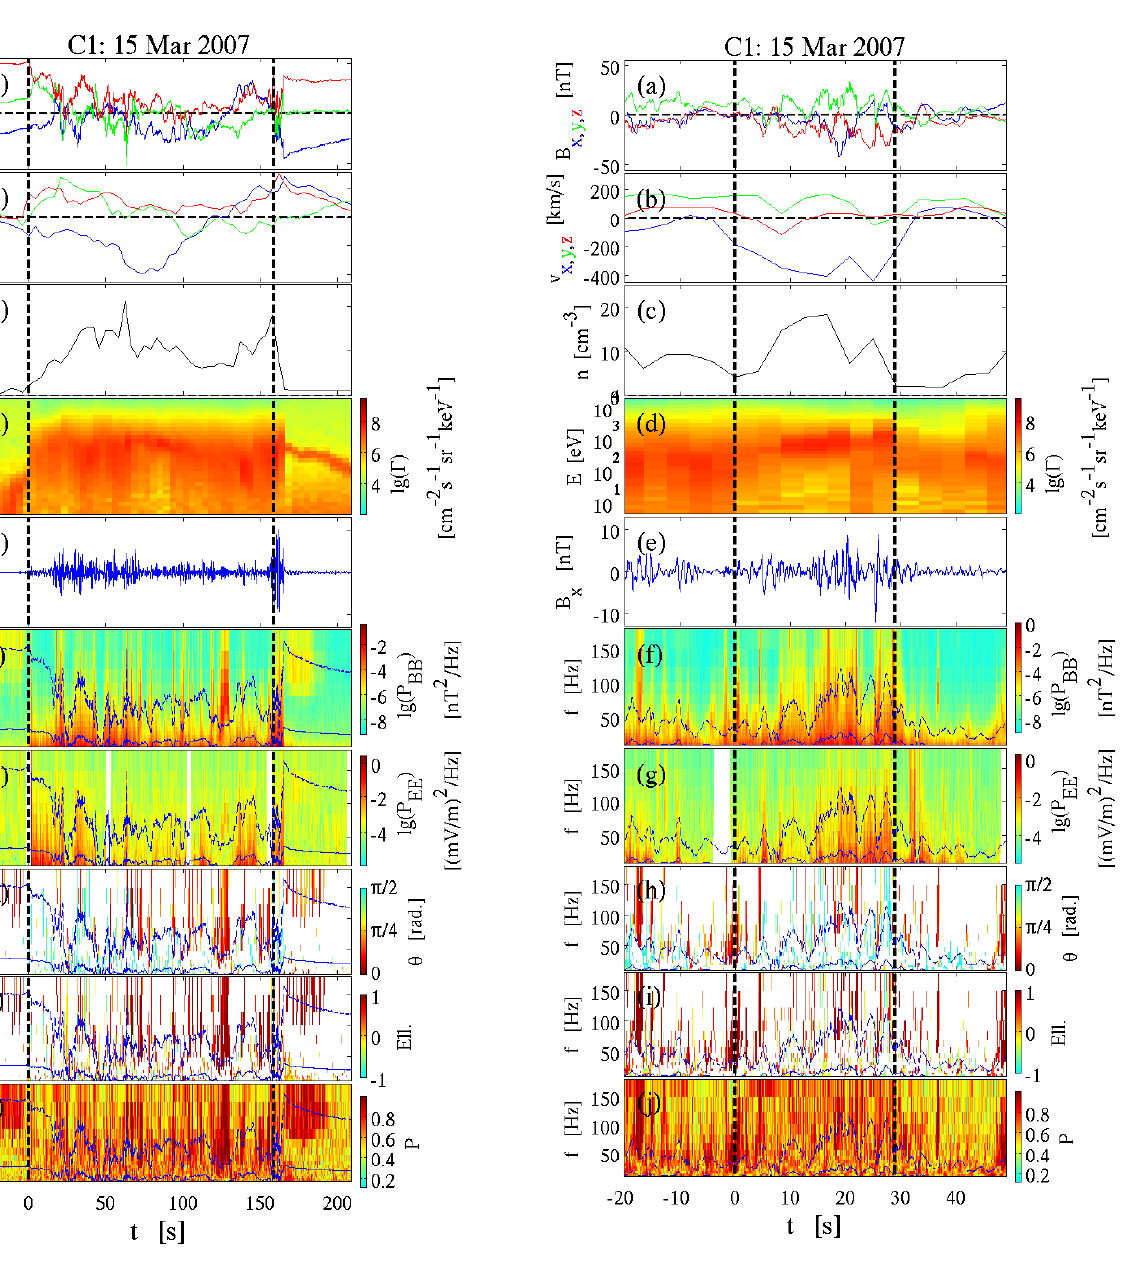
Figure 6. Data obtained by Cluster 1 on 15 March 2007. On the horizontal axis, time t = 0 corresponds to 08:00:39UT. (a) Mag- netic flux density in GSE coordinates; (b) ion bulk velocity in GSE coordinates; (c) ion density; (d) omnidirectional ion energy spectrum; (e) the x component of B measured by STAFF in the 0 . 6 Hz ≤ f ≤ 180 Hz frequency range; (f) power spectral density of | B | ; (g) power spectral density of | E | ; (h) propagation angle, i.e. the angle between k and B ; (i) ellipticity; (j) degree of polarisation. The vertical dashed lines mark the beginning and end of the plas- moid identified in Table 1. The blue curves on panels (f–j) show 0 . 1 f ce (upper curve) and f lh (lower curve).